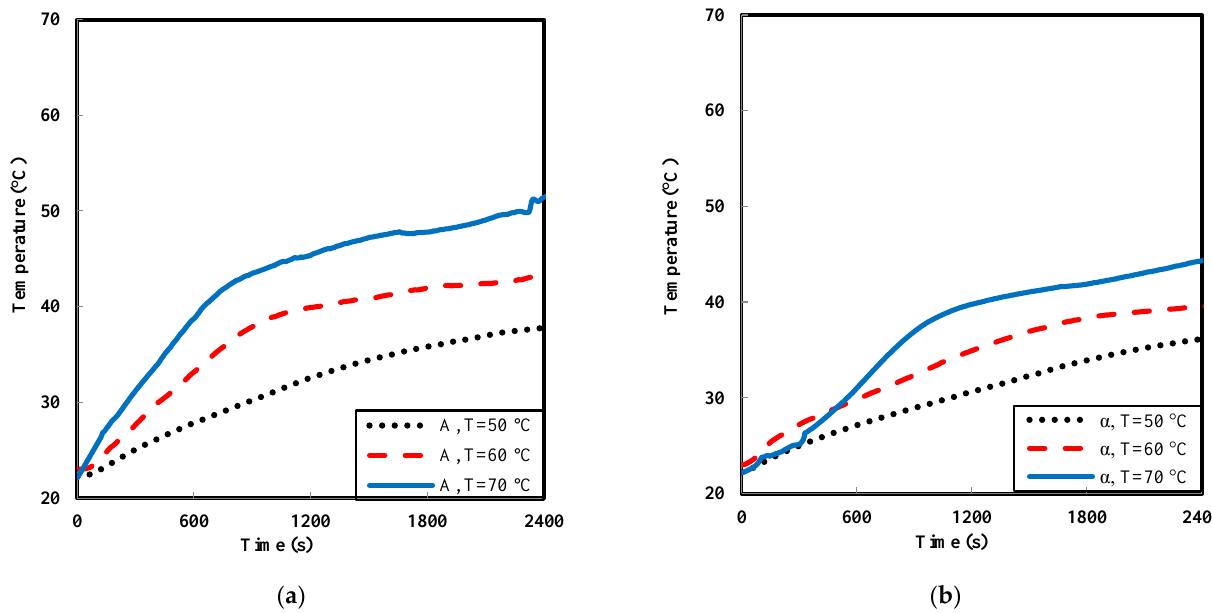
Figure 7. Influences of the bathwater temperature on the charging process, T = 50 °C, 60 °C, and 70 °C for ( a ) Athemocuples in the radius of 6 mm and ( b ) α thermocouples in the radius of 13 mm.